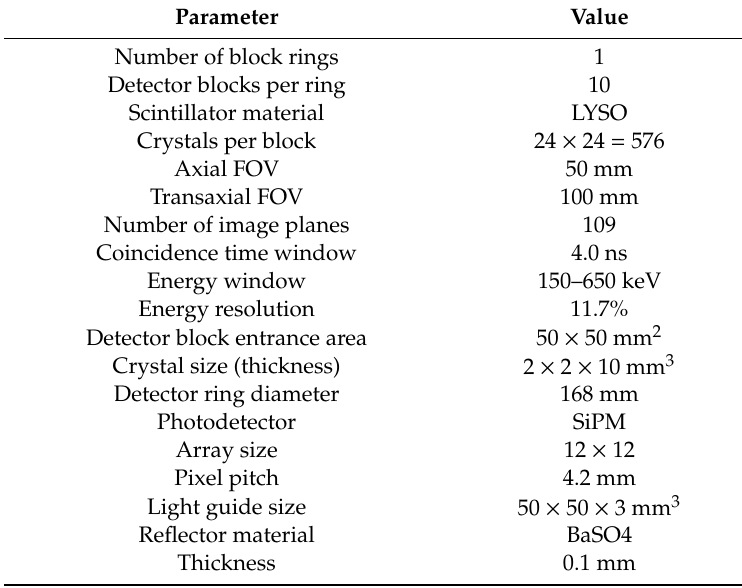
Table 1. Physical characteristics and dimensions of the preclinical positron emission tomography (PET) scanner used for the validation of GEANT4 Monte Carlo